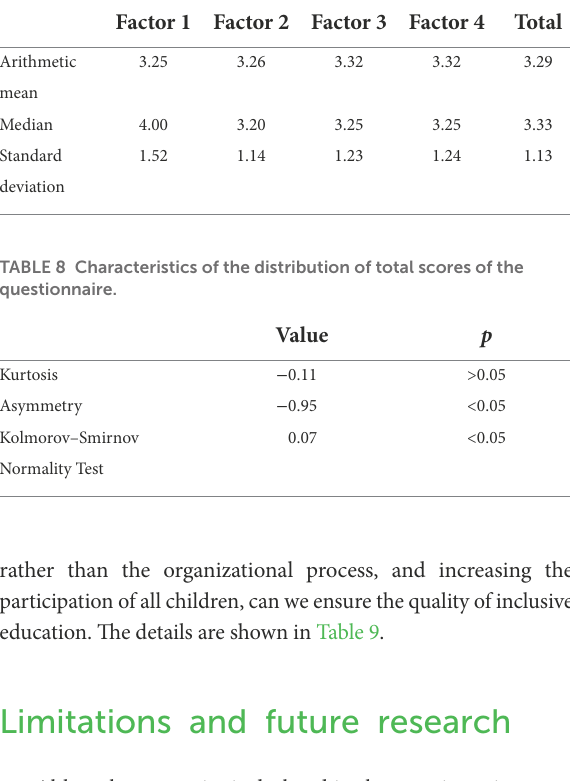
TABLE 7 Measures of central tendency and variability.